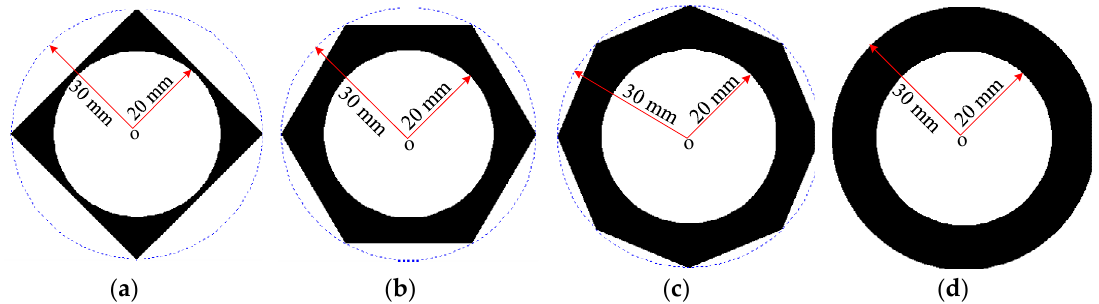
Figure 3. Cross sections: ( a ) A square drill pipe; ( b ) a hexagonal drill pipe; ( c ) an octagonal drill pipe; ( d ) the referential hollow cylinder.